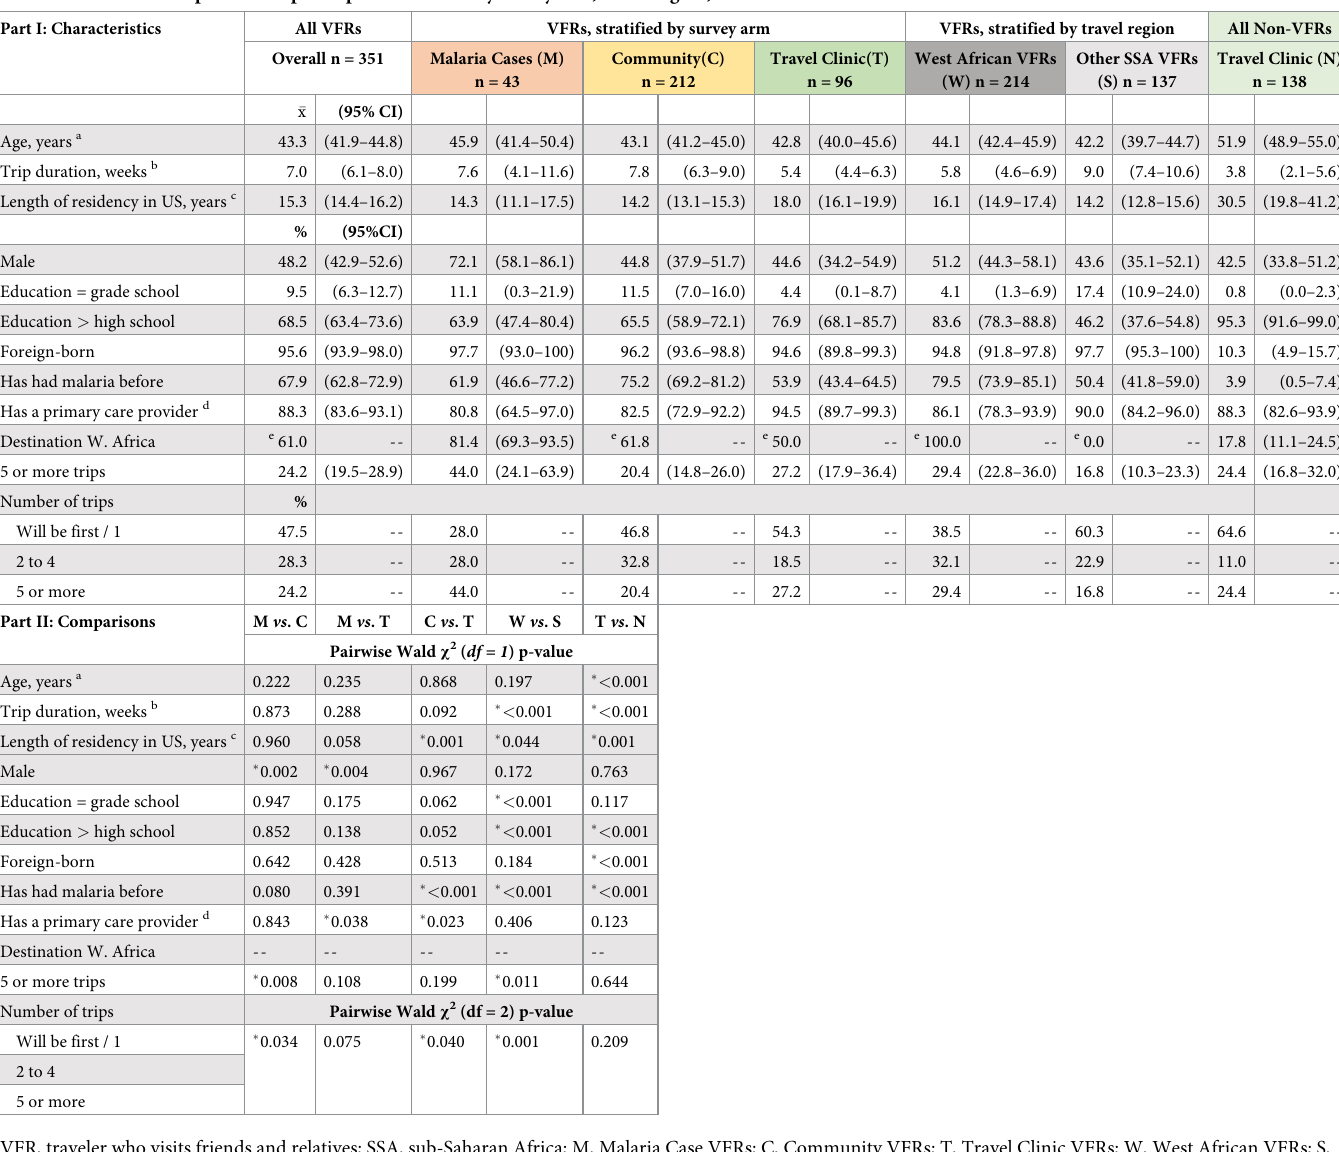
Table 1. A cross-sectional, multi-setting survey of malaria prevention knowledge, attitudes, and practices among US travelers to sub-Saharan Africa: Demographic characteristics and comparisons of participants stratified by survey arm, travel region, and reason for travel. Part I: